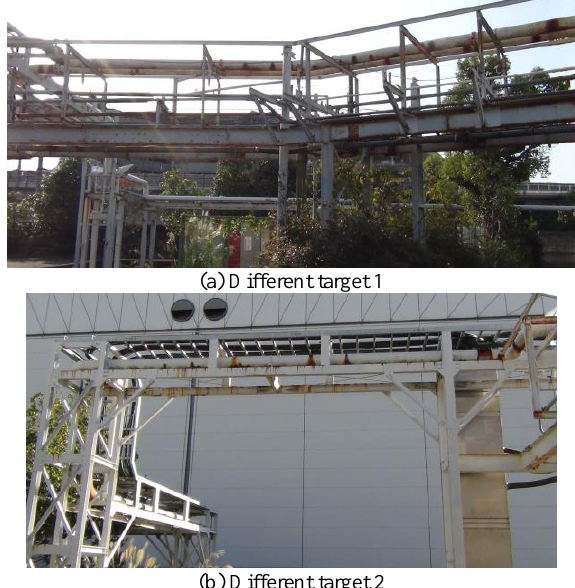
Figure 12. RGB image for second test target.